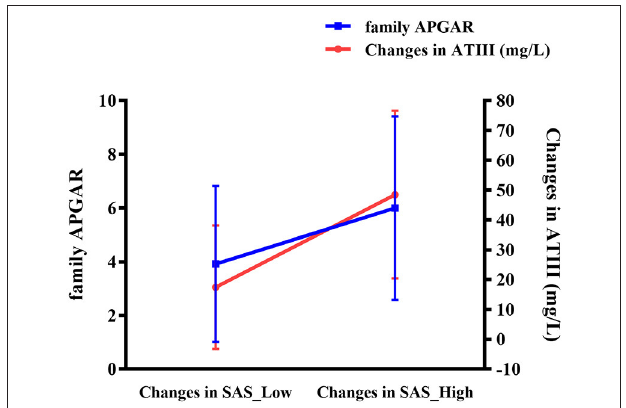
FIGURE 3 | Interaction of altered ATIII (mg/L) and family APGAR on change in SAS in the individualized group. ATIII, antithrombin III; APGAR, Adaptation, Partnership, Growth, Affection, Resolve; SAS, Self-Rating Anxiety Scale.